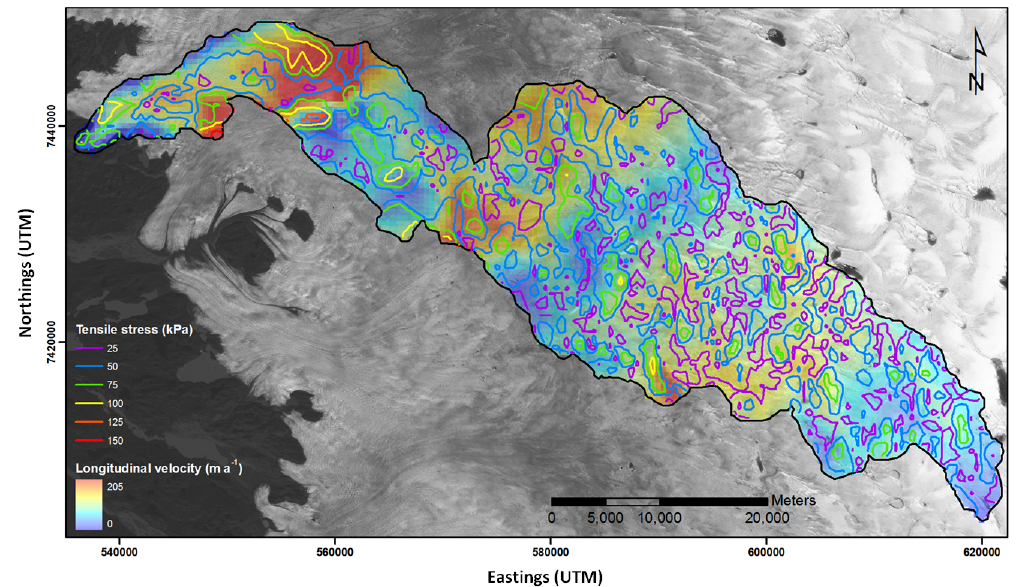
Figure 2. Longitudinally resolved (along-flow) ice surface velocities from InSAR data for the Leverett catchment (Joughin et al., 2010). Contours depict the ice surface tensile stress